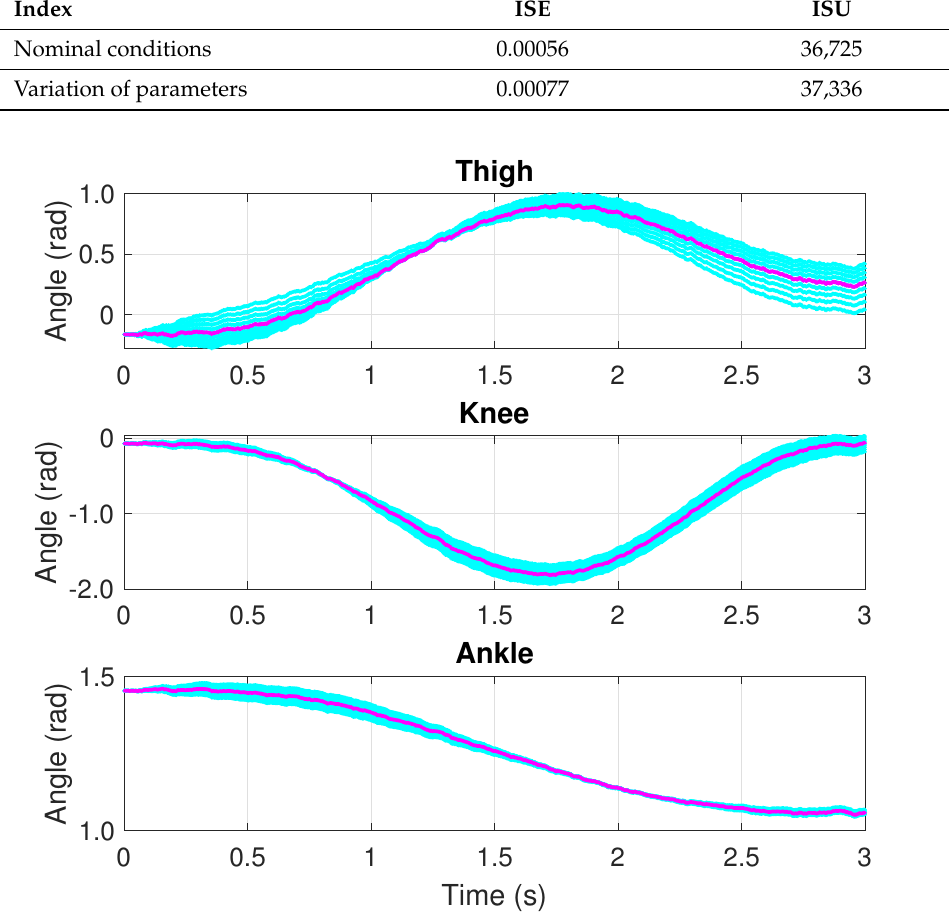
Figure 9. Nonlinear control robustness test against parameter variation. (Nominal behavior: central line, parameters variation: